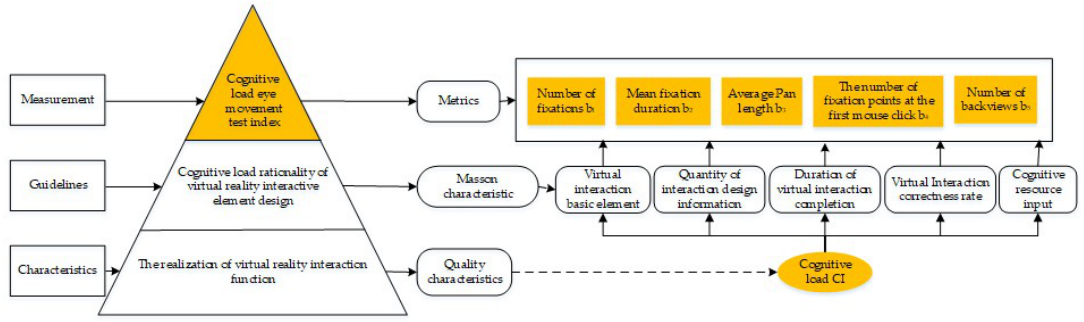
Figure 1. Multi-modal interactive information integration model in a virtual reality system.